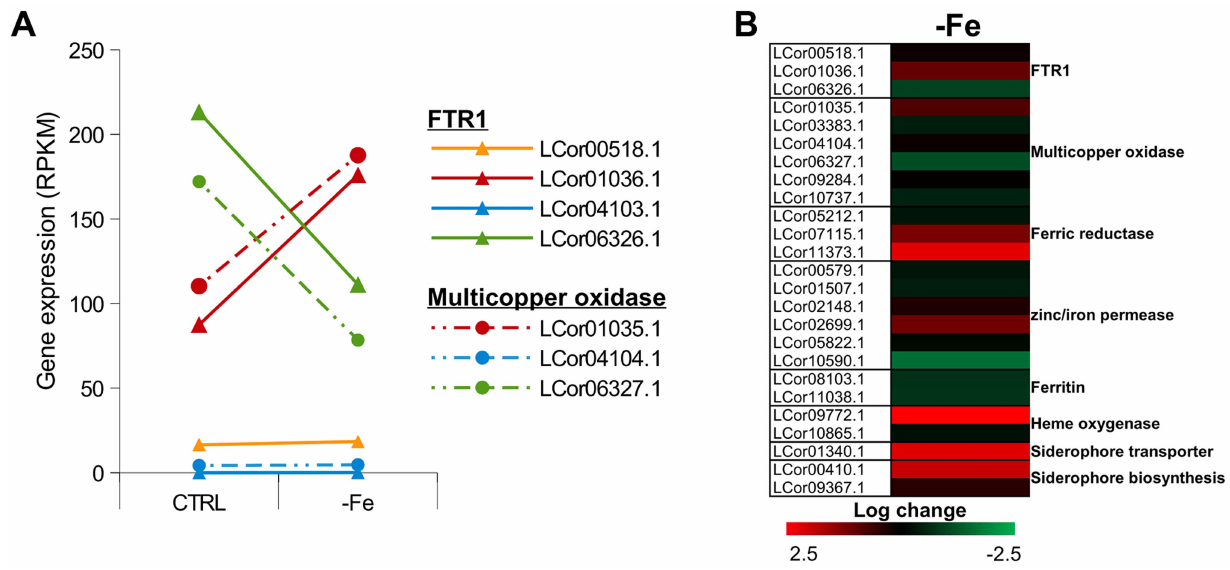
Figure 5. Expression of iron uptake genes under iron limited conditions. (A) Expression levels of FTR1 domain genes and their corresponding multicopper oxidases under standard conditions and iron limitation. (B) Heat map showing the regulation of iron uptake genes under iron-limited conditions.